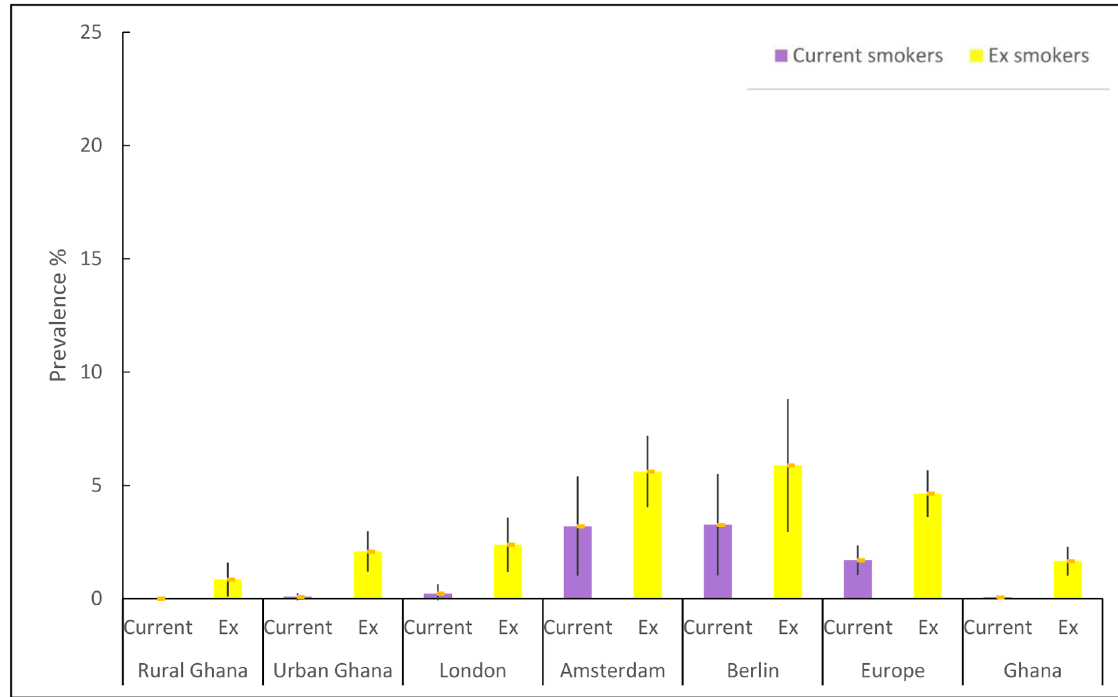
Fig 3. Age-standardized prevalenceof current and ex-smokers among women.